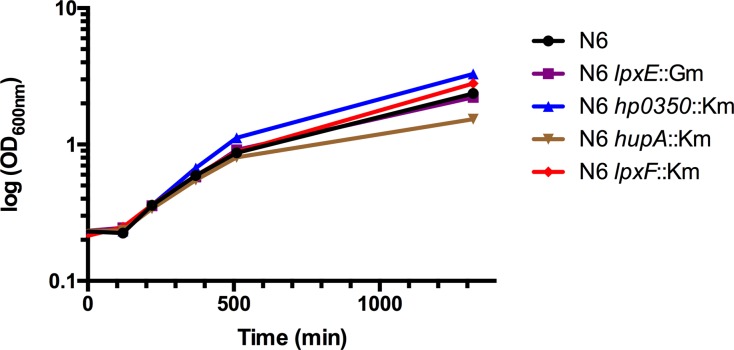
Growth curves of Helicobacter pylori N6.WT (black) and the four single mutants lpxE∷Km (purple), hp0350∷Km (blue), hupA∷Km (brown) and lpxF∷Km (red) were grown with classic conditions previously described in Bacterial strains, plasmids and bacterial growth conditions section.